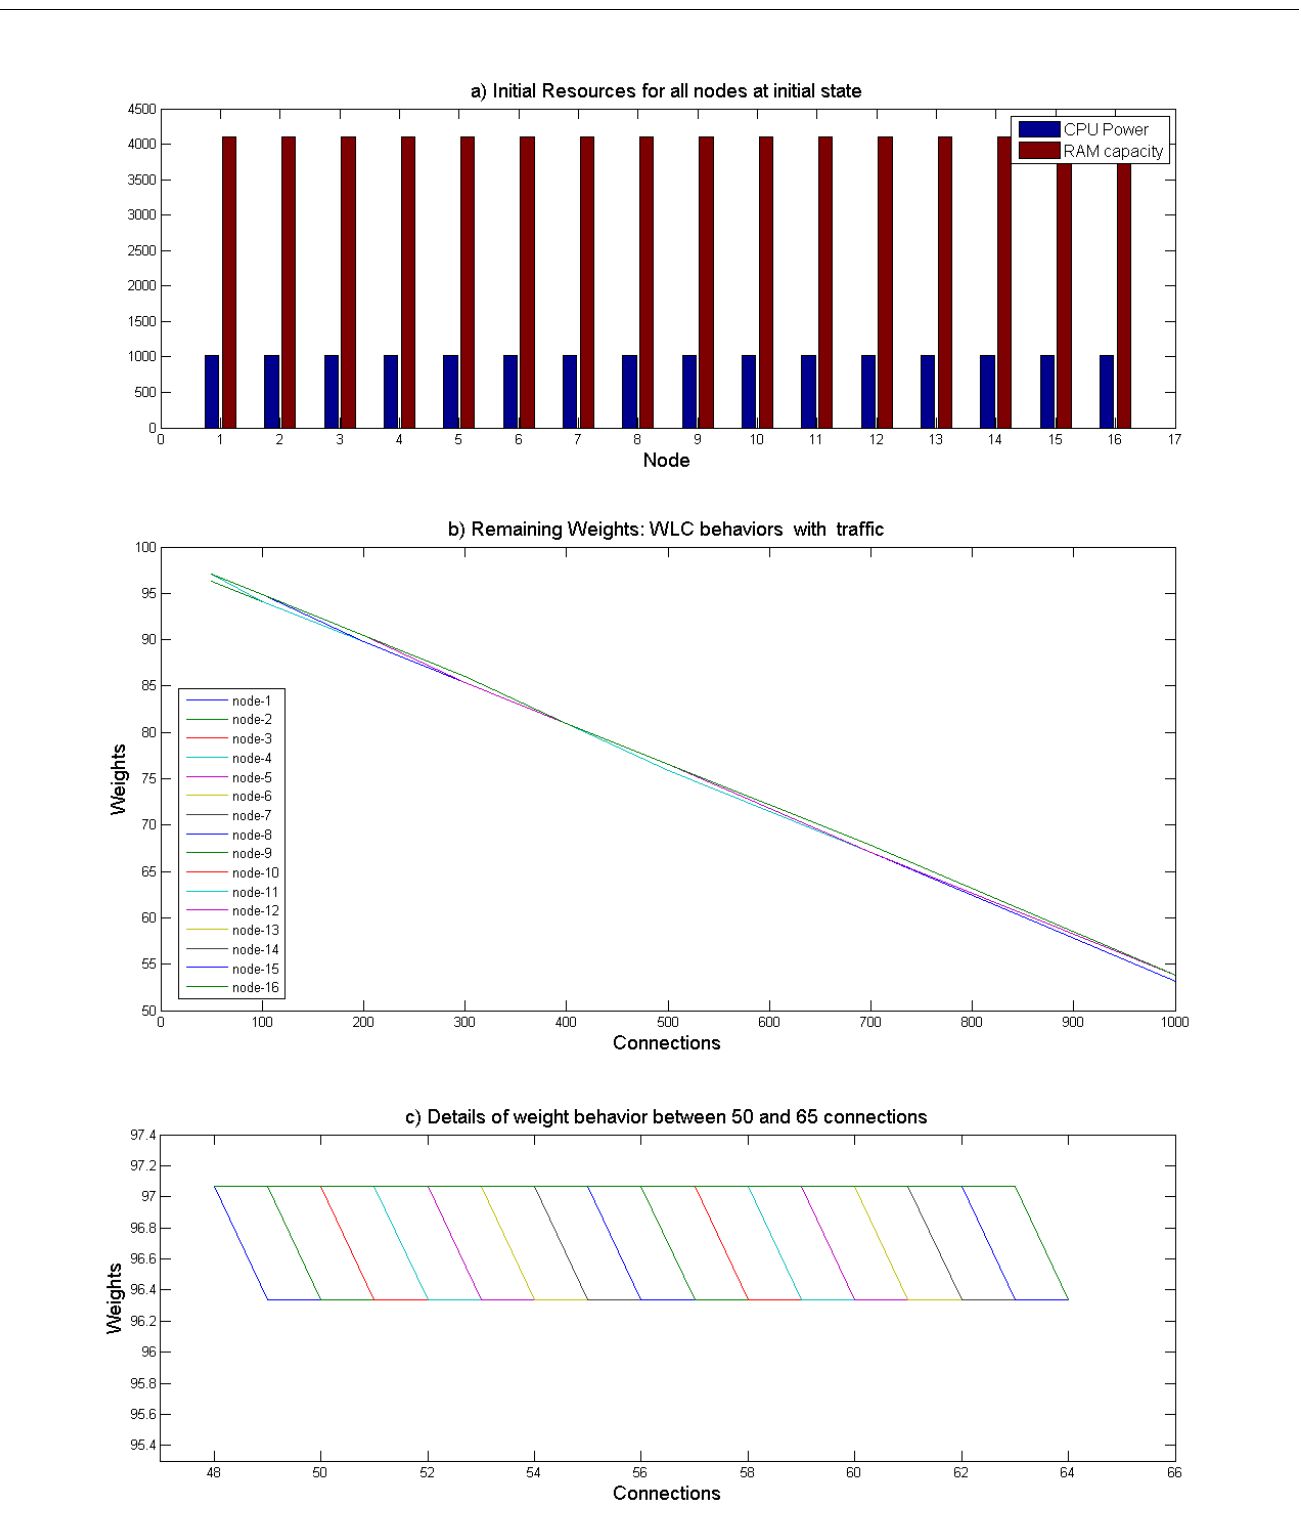
Figure 6. Validation of the WLC algorithm using 16 similar nodes. the WLC behavior demonstrates the validity of the WLC